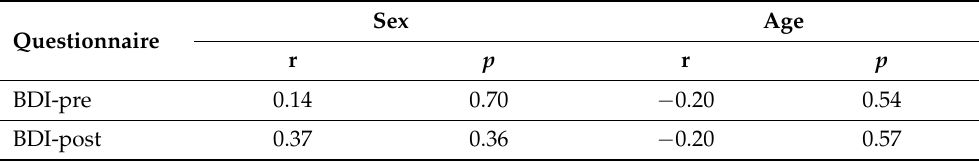
Table 4. MDD REAL-Responder correlations between sex/age and questionnaires.